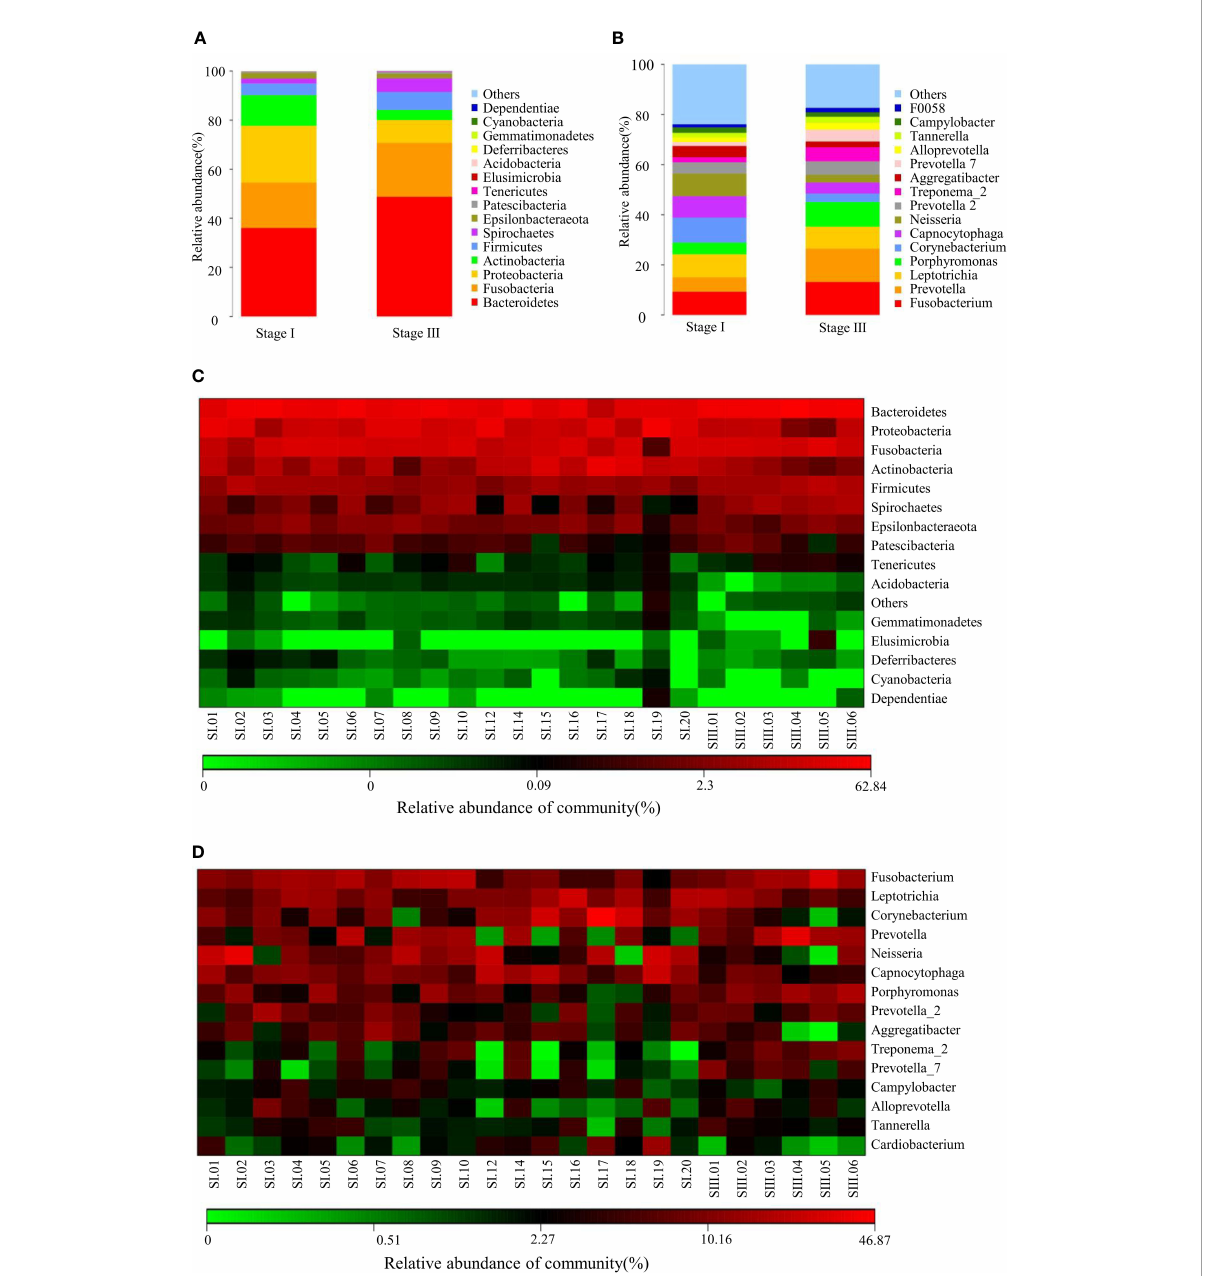
FIGURE 1 Composition of the oral microbiome between samples from women with stage-I or stage-III periodontitis at phylum (A) and genus (B) levels. Heatmaps at phylum (C) and genus (D) levels: the horizontal denotes sample information, and the vertical denotes information on species annotation. Colors indicate the relative abundance of a microbial